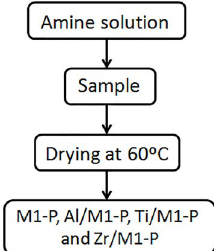
Figure 2. Schematic diagram of the procedures for obtaining adsorbents impregnated with